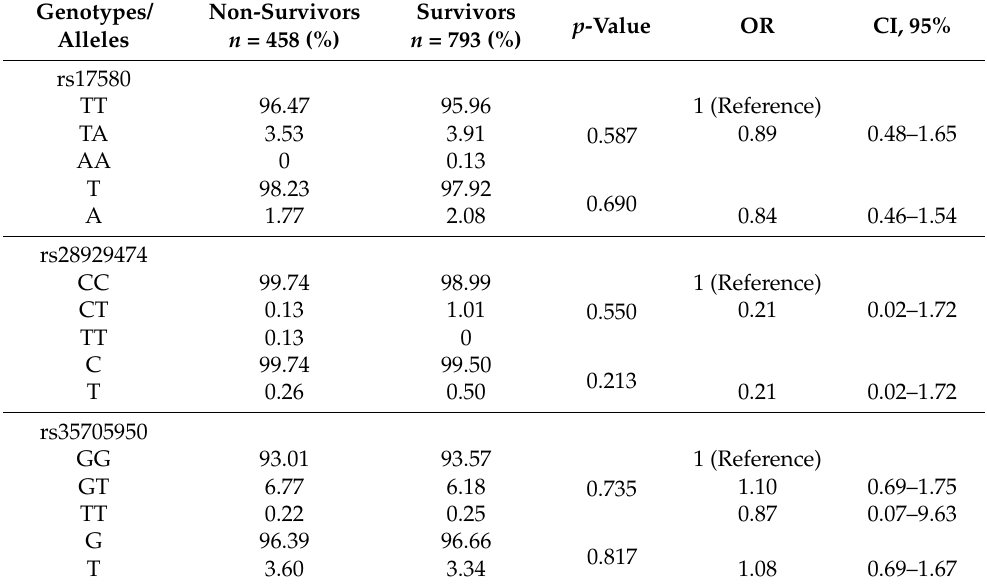
Table 2. Genotype and allele frequencies of SERPINA1 and MUC5B polymorphisms in patients with COVID-19 discharged due to death or